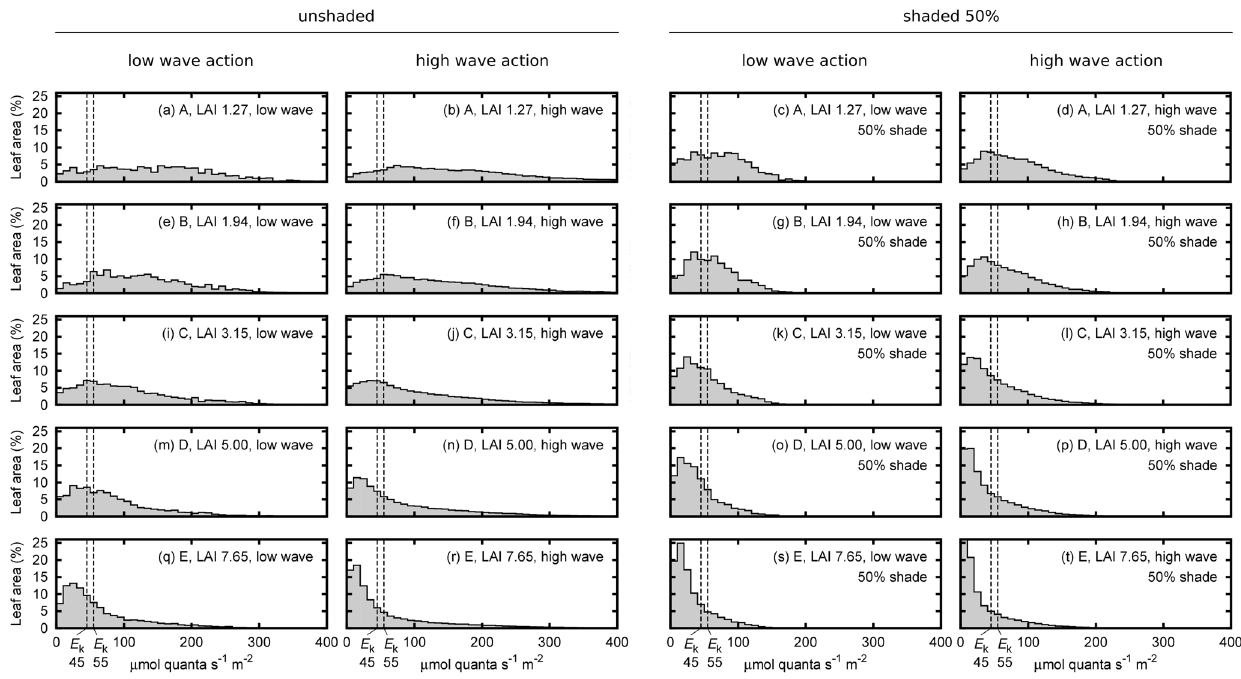
Figure 4. Distribution of leaf saturation state in the canopy in terms of percentage of leaf area at midday. Treatments are upright low wave action canopy positions and the average over the high wave action movement positions (left columns), and the same for 50% shading (right columns), for the five LAI treatments. The estimated photosynthetic saturation irradiances, E k , of 45 and 55 m mol quanta m 2 2 s 2 1 inferred from Masini and Manning (1997) are shown as vertical dotted lines.